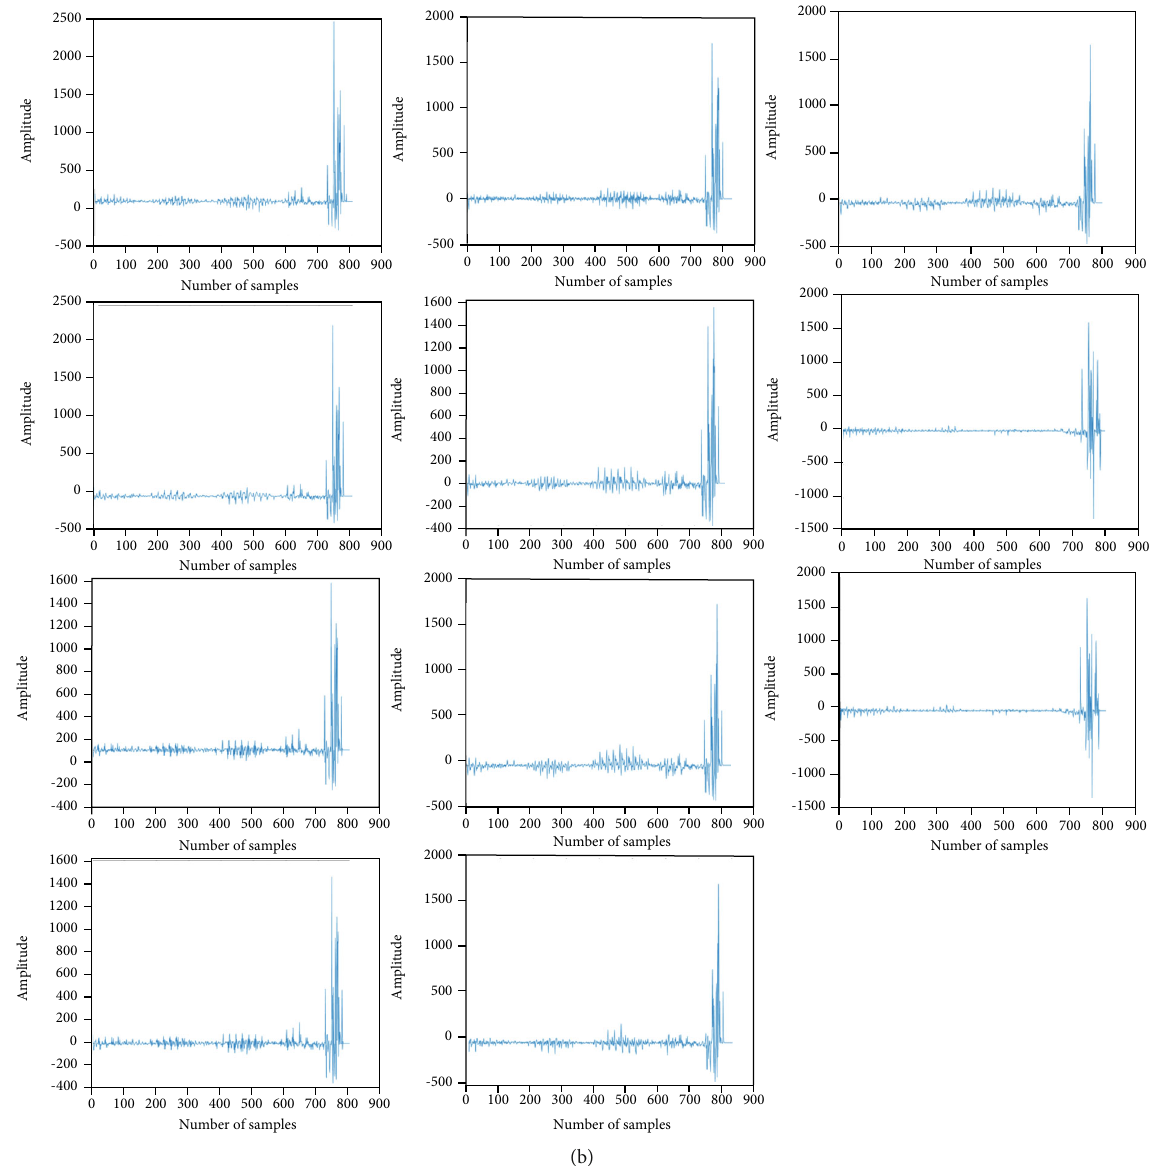
Figure 3: Experimental outcomes: (a) input EEG signal and (b) DWT feature